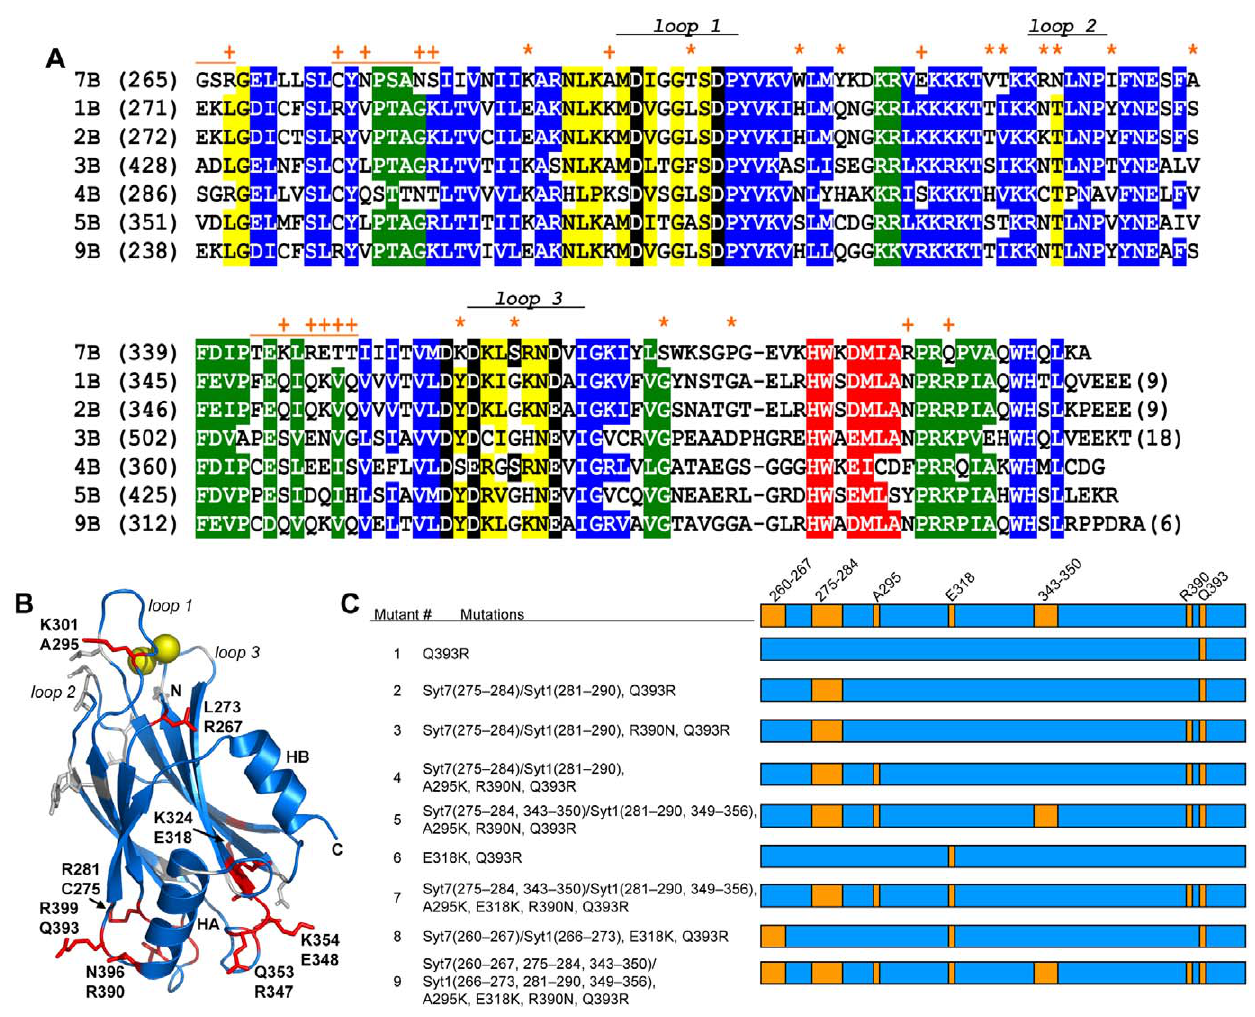
Figure 2. Sequence differences between the C 2 B domains of synaptotagmins-1 and -7. (A) Sequence alignment of the C 2 B domains from selected rat synaptotagmin isoforms illustrating the similarities and differences among them. The first residue number of each sequence in each line is indicated in parenthesis. Conserved residues are color-coded: blue, b -strands; red, helix HA; yellow, top loops; green, bottom loops; black, Ca 2 + ligands. The positions of the three Ca 2 + -binding loops (loops 1–3) are indicated. Residues that are identical in the C 2 B domains of synaptotagmins-1, - 2 and -9 (the three isoforms that can support fast neurotransmitter release in cortical synapses [8]), but are different in the C 2 B domain of synaptotagmin-7, are indicated by a + sign if they were mutated in the Syt1/7 chimeras (see panel C), or by a * otherwise. The orange lines above the synaptotagmin-7 C 2 B domain sequence indicate the positions of fragments in the linker or loop sequences that were replaced with those of synaptotagmin-1 in the Syt1/7 chimeras (see panel C). (B) Ribbon diagram of the NMR structure of the synaptotagmin-1 C 2 B domain [17] illustrating the positions of selected residues mutated in the Syt1/7 chimers (shown as red stick models). The corresponding residue names (in single letter amino acid code) and numbers in synaptotagmin-1 are indicated above, and those in synaptotagmin-7 are indicated below. The bound Ca 2 + ions are shown as yellow spheres. The positions of the Ca 2 + -binding loops and the two helices (HA and HB) are indicated. (C) Summary of chimeric Syt1/7 mutants used in this study. As illustrated in Figure 1C, Syt1/7 WT is composed of residues 1–265 of synaptotagmin-1 and the WT C2B domain (residues 260–403) of synaptotagmin-7. Each of the Syt1/7 mutants is composed of the same residues of synaptotagmin-1 (residues 1–265) and synaptotagmin-7 (residues 260–403) (represented in blue in the diagrams), but with the indicated mutations (illustrated by the orange boxes in the diagrams). The residue numbers of mutations are based on the respective WT synaptotagmins-1 and -7. In addition to point mutations, several stretches of residues in the synaptotagmin-7 C2B domain were changed to the corresponding residues in the synaptotagmin-1 C2B domain. These changes are listed as Syt7(residues)/Syt1(residues). For example, in Syt1/7 mutant # 5, the synaptotagmin-7 residues 275–284 and 343–350 were replaced by the synaptotagmin-1 residues 281–290 and 349–356,